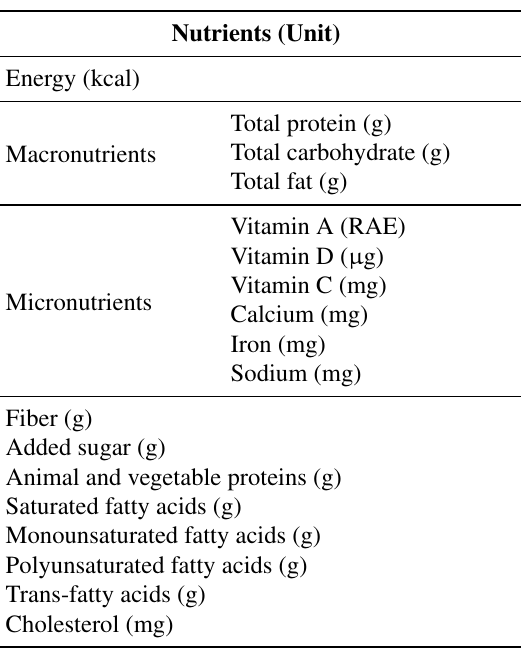
Table 1. Energy, micro and macronutrient final outcomes in Latin American Study of Nutrition and Health